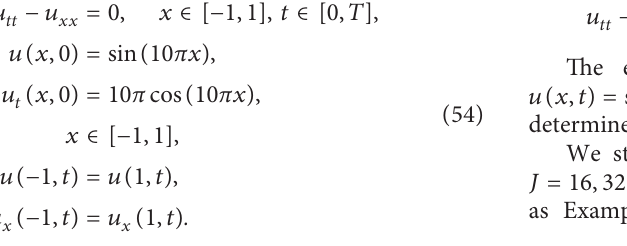
( x, t )‖ versus x at T � 100 by P 2 (a) and P 3 (b) for Example h